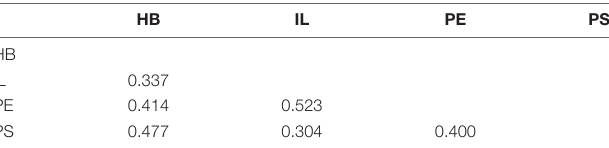
TABLE 4 | Heterotrait-monotrait ratio